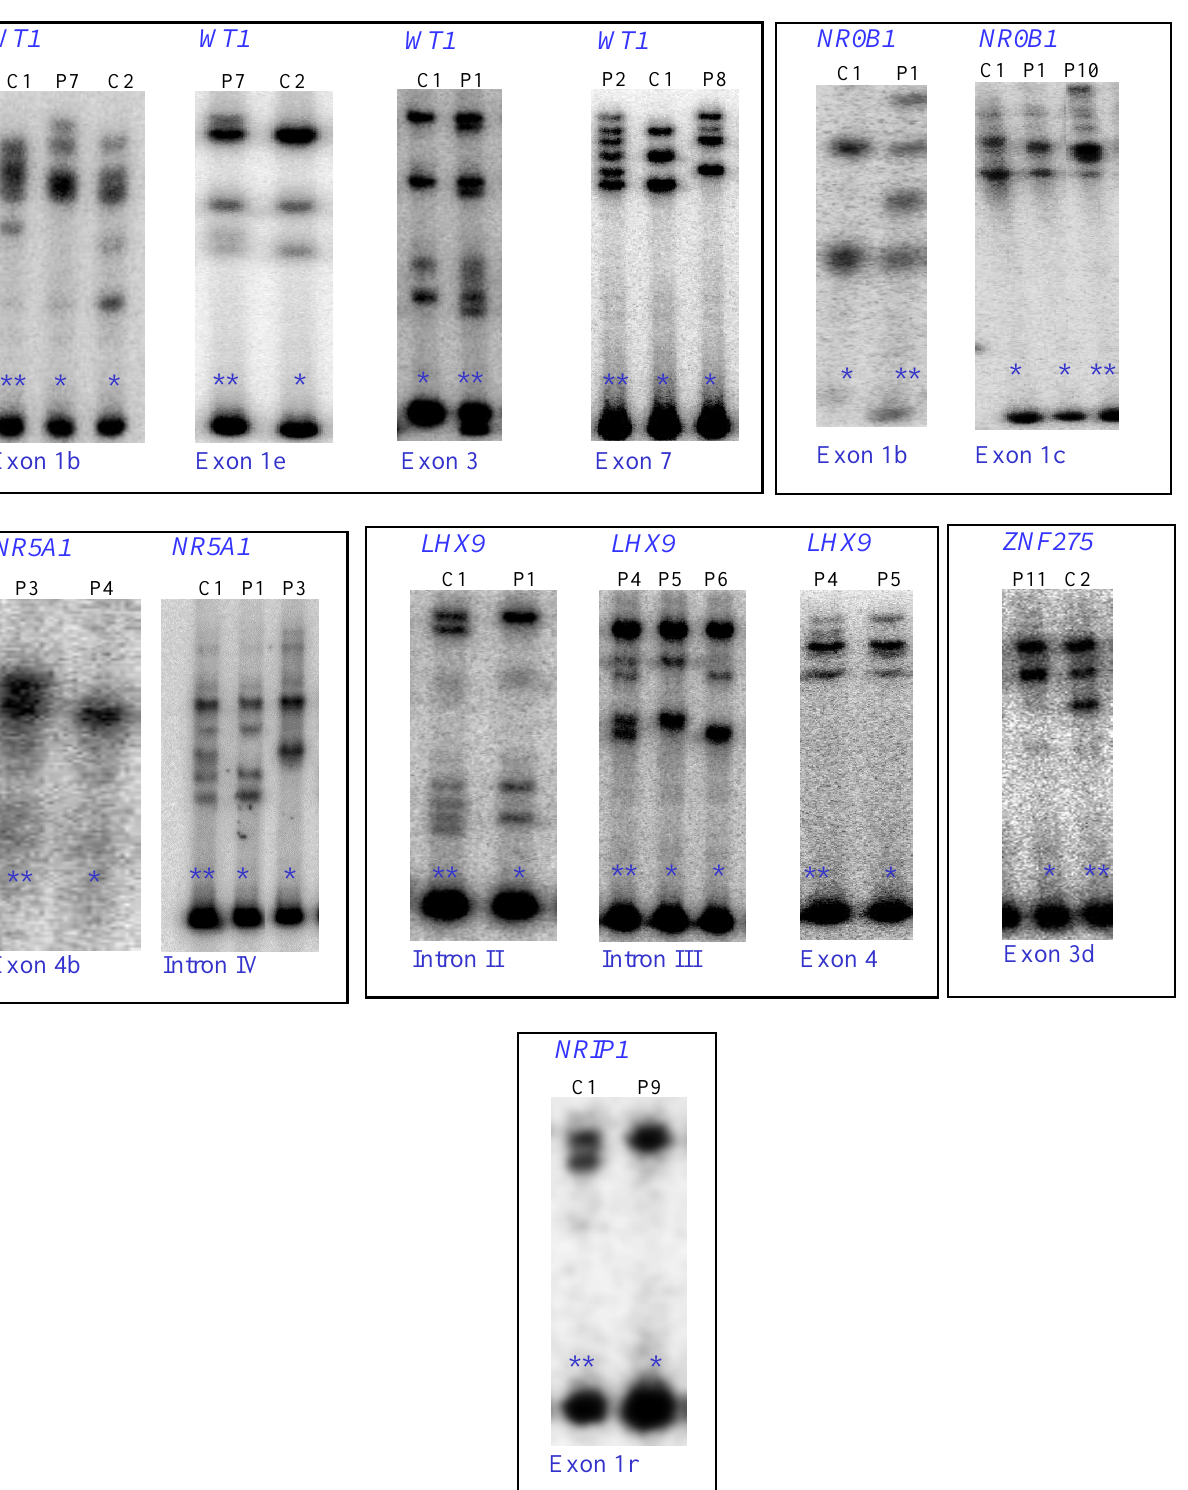
Figure 2. Genetic variants identified using ( α - 32 P)-dCTP-PCR-SSCP analysis of the WT1 (NM_024426.6), NR0B1 (NM_000475.5), NR5A1 (NM_004959.5), LHX9 (NM_020204.3), ZNF275 (NM_001080485.4), and NRIP1 (NM_003489.4) genes from patients with POI (P) and healthy subjects (C). Different SSCP patterns are marked by asterisks. Heterozygous and homozygous subjects are indicated by two and one asterisks,